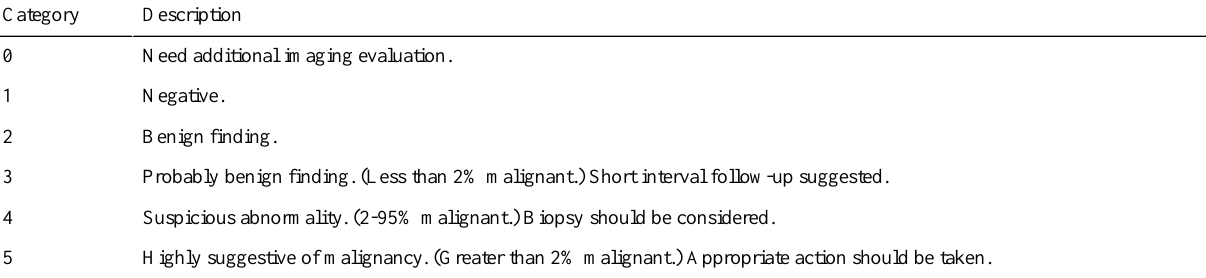
Table 1. BI-RADS a assessment